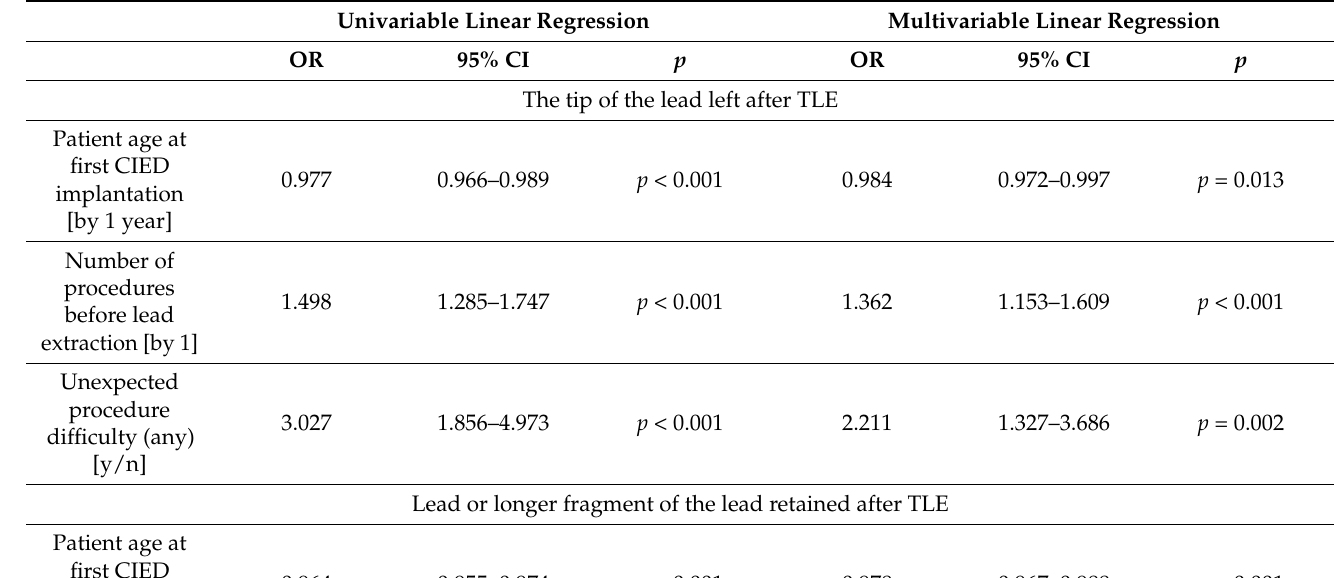
Table 4. Predictive factors for retention of lead fragments after TLE in univariable and multivariable regression